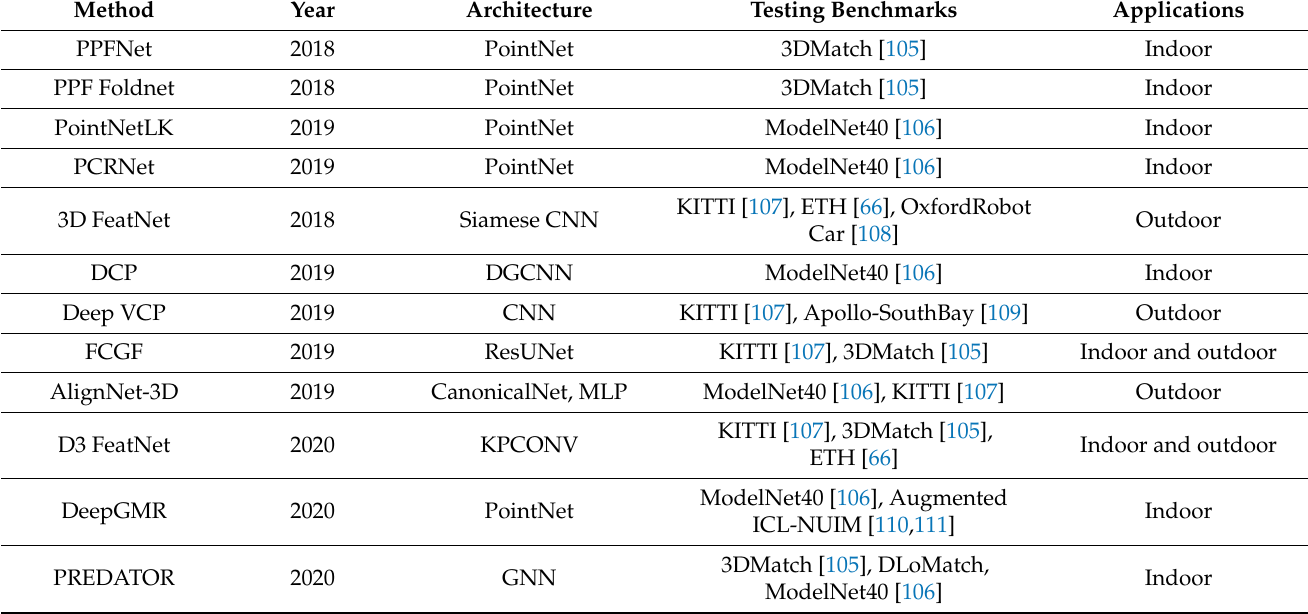
Table 5. Deep-learning registration